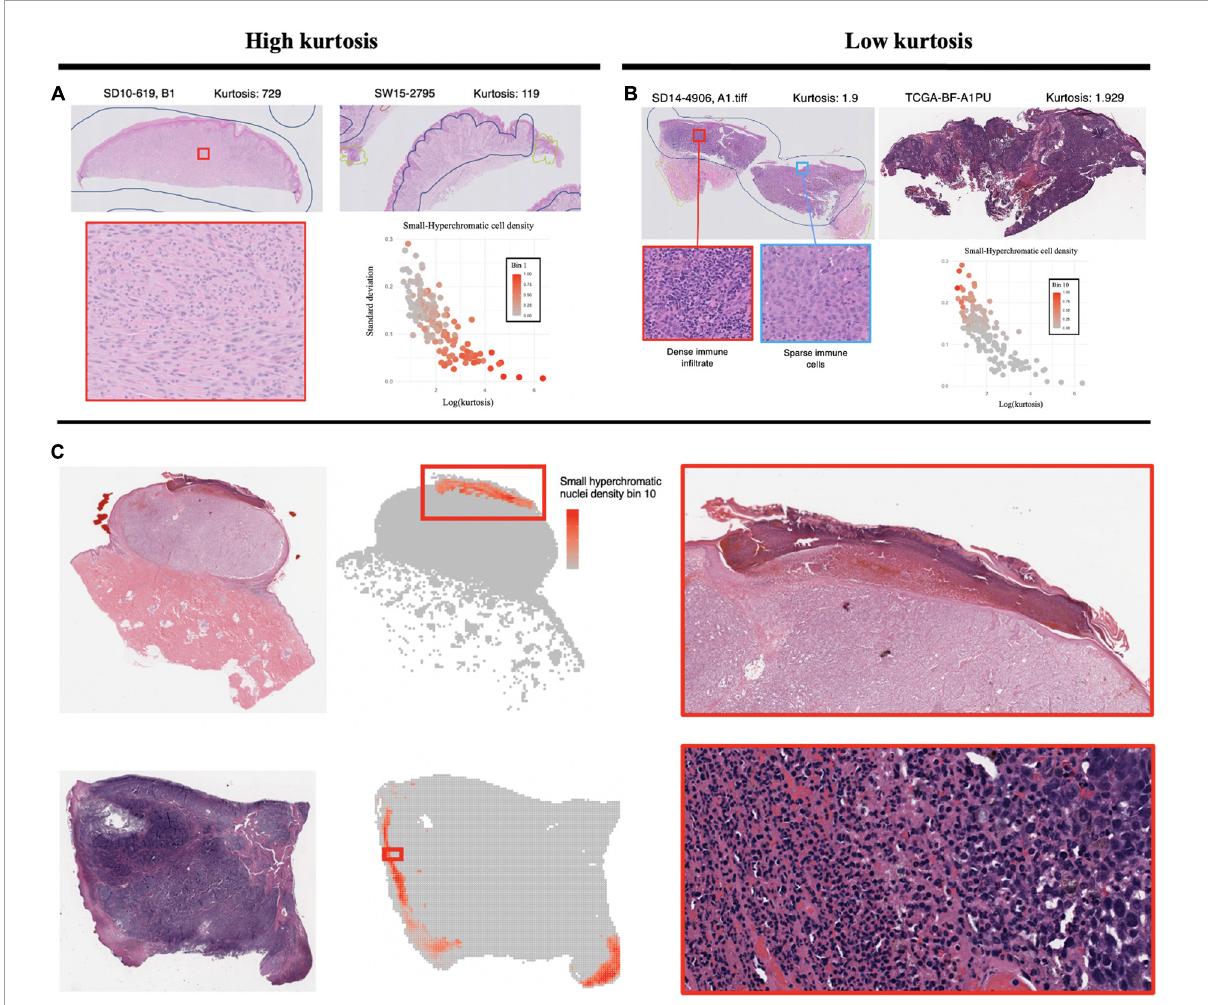
FIGURE5 Visualization of small, hyperchromatic nuclei. (A) Demonstrates high kurtosis of Small-Hyperchromatic cells. These slides have uniformly low densities of immune infiltration. (B) Low kurtosis of Small-Hyperchromatic cells shows slides with a high variability of immune infiltration and necrosis across the entire specimen. Kurtosis of this feature is inversely correlated with standard deviation, and slides with high kurtosis have lower densities of Small-Hyperchromatic cells. In (C) , binl0 represents the highest density of Small-Hyperchromatic cells. Like the slides with low kurtosis in panel (B) , these high-density regions harbor necrosis of tissue with dense lymphocytic and neutrophilic infiltrate. Slides with low kurtosis have a higher standard deviation and higher density of Small-Hyperchromatic cells. The convolutional neural networks (CNN) used to filter out background patches in this visualization was trained on the clinical proteomic tumor analysis consortium (CPTAC)